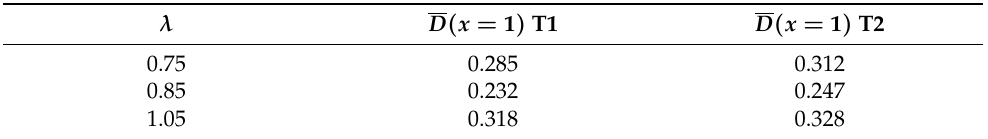
Figure 19. Summary of the kinetic energy components of turbine T1 (red) and T2 (blue) at x / D t = 1.0 averaged over space and time. Table 1. Comparison of each configuration temporally and spatially averaged divergence at x / D t =